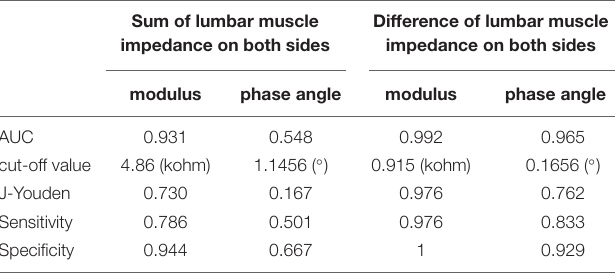
TABLE 3 | Area under the receiver operator characteristic curves for ability to predict pain for lumbar muscle impedance of helicopter pilots. Sum of lumbar muscle Difference of lumbar muscle impedance on both sides impedance on both